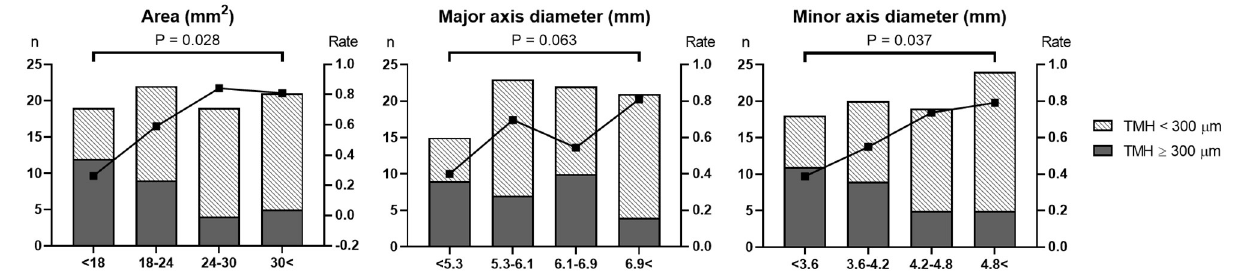
Fig 2. Distributions and rates of tear meniscus height (TMH) normalization ( < 300 μ m) at 3 months after tube removal according to the smallest bony nasolacrimal duct parameters. The P values were derived from Fisher’s 2 × 4 tests.